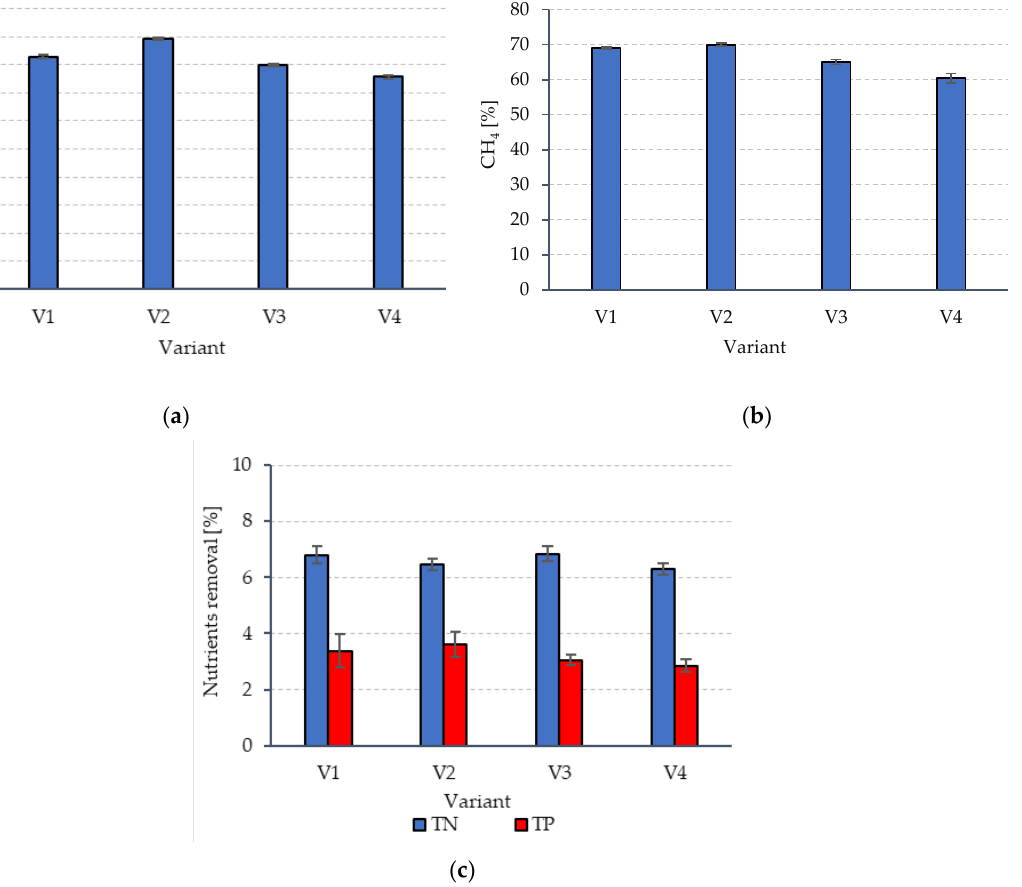
Figure 5. The efficiency of anaerobic dairy treatment in stage 2: ( a ) organic compound removal as COD with a standard deviation in experimental variants V1–V5; ( b ) CH 4 concentration in biogas with a standard deviation in experimental variants V1–V5; ( c ) nutrient removal (nitrogen and phosphorus) with a standard deviation in experimental variants V1–V5.